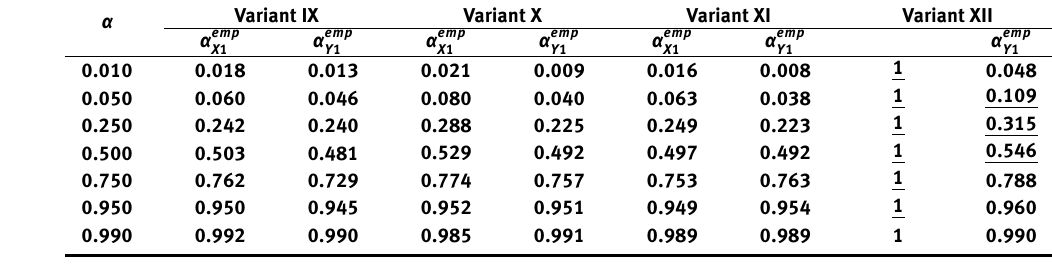
α Variant IX Variant X